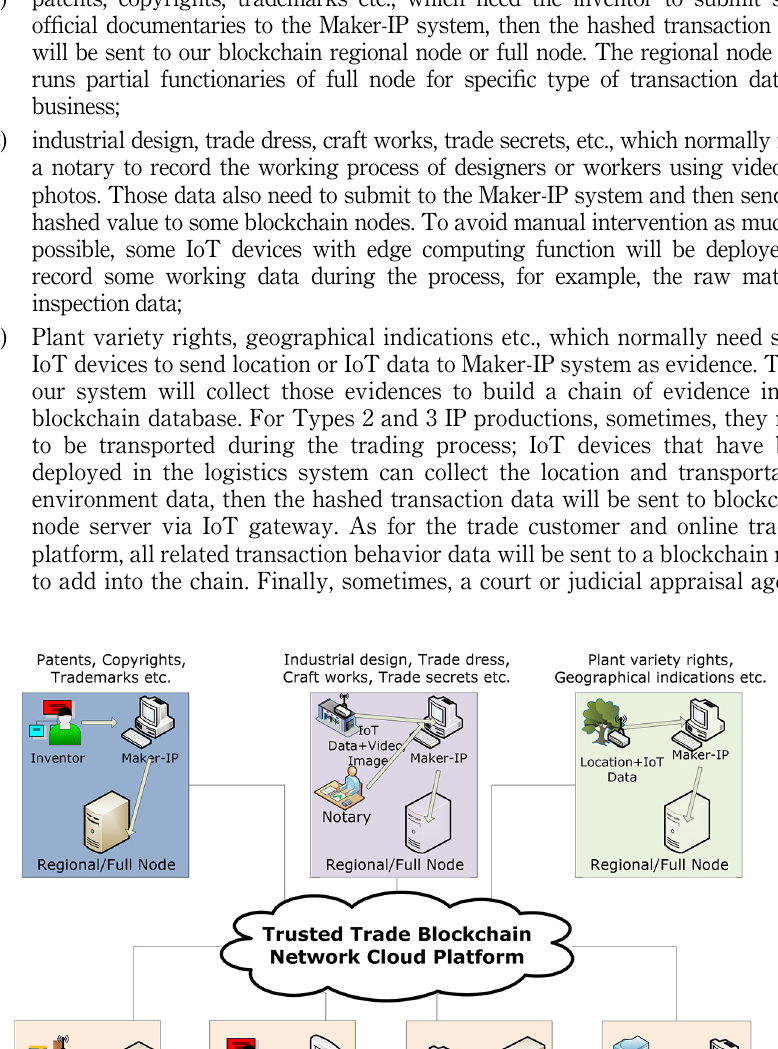
Figure 1. Blockchain and